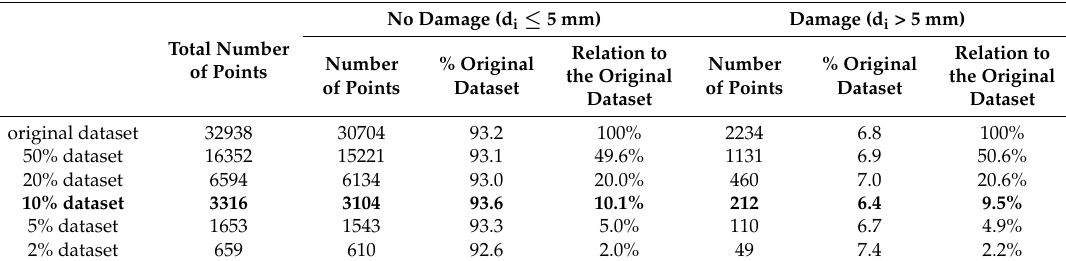
Table 2. Results of processing with the random method—concrete sample.